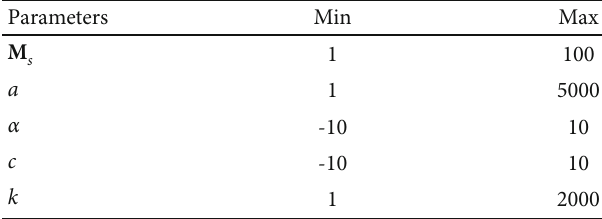
Table 1: The search space of identi fi cation parameters.